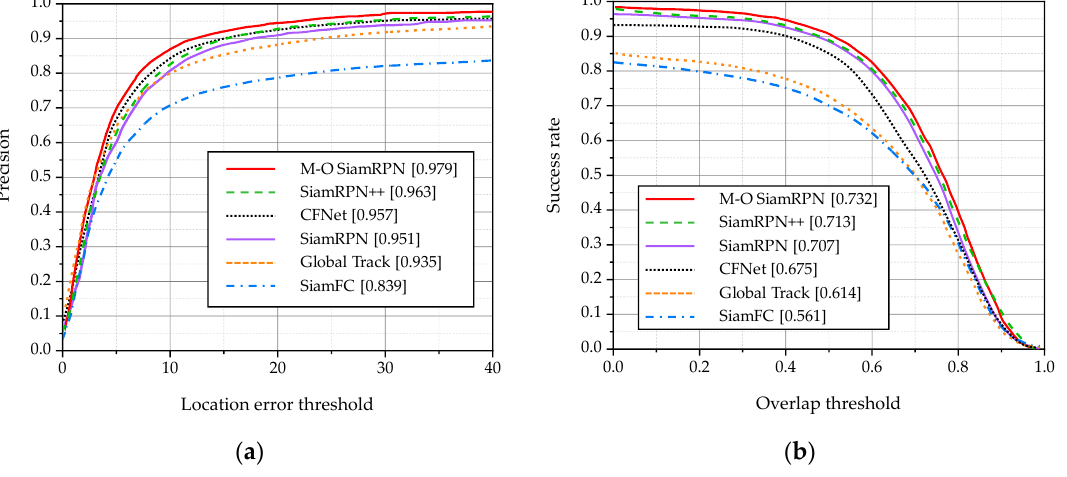
Figure 11. Precision and success plots of M-O SiamRPN with multi-optimization and state-of-the- Figure 11. ( a ) Precision and ( b ) success plots of M-O SiamRPN with multi-optimization and state-of- art frameworks. The mean precision and AUC scores are reported for each framework. the-art frameworks. The mean precision and AUC scores are reported for each Table 1. The FPS and CLE of different localization frameworks.